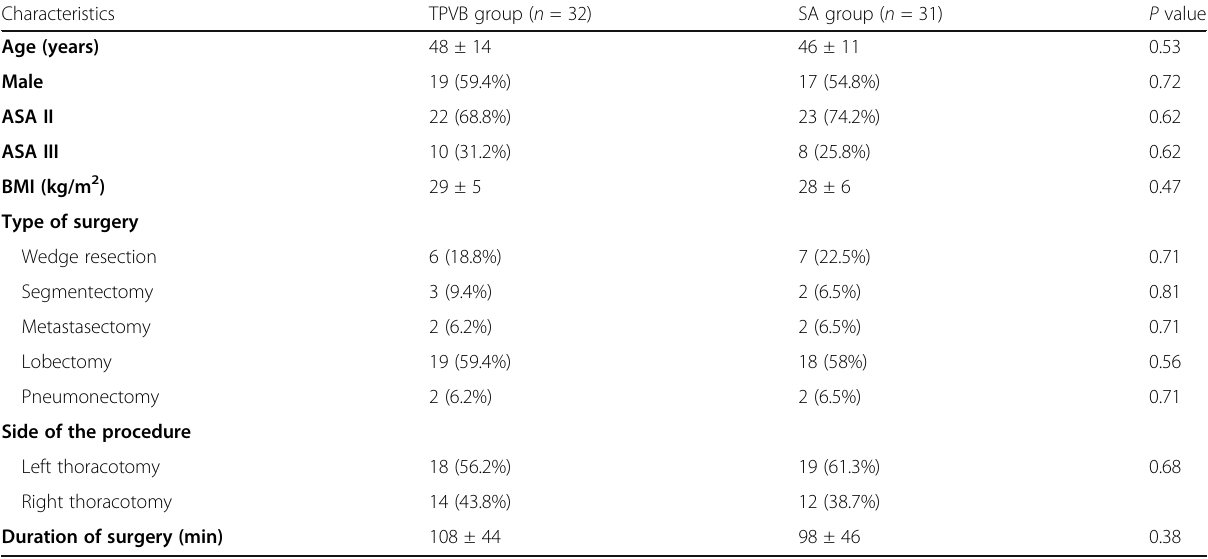
Table 1 Characteristics of patients and surgical procedures Characteristics